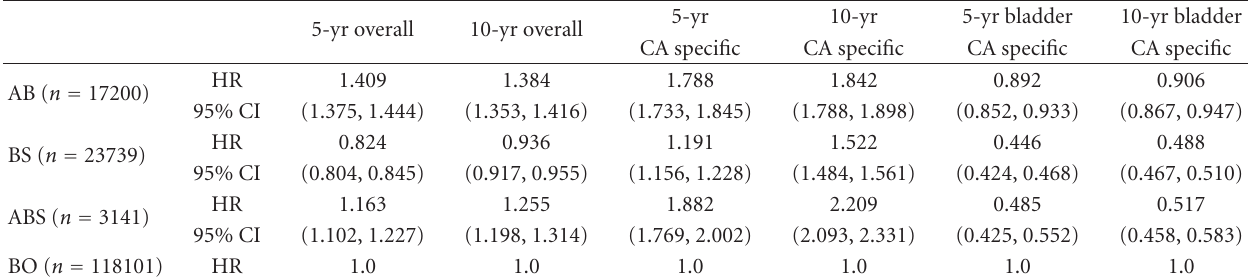
Table 3: Survival rates and Cox hazard ratios representing AB, BS, ABS, and BO cohorts, multivariate analysis.